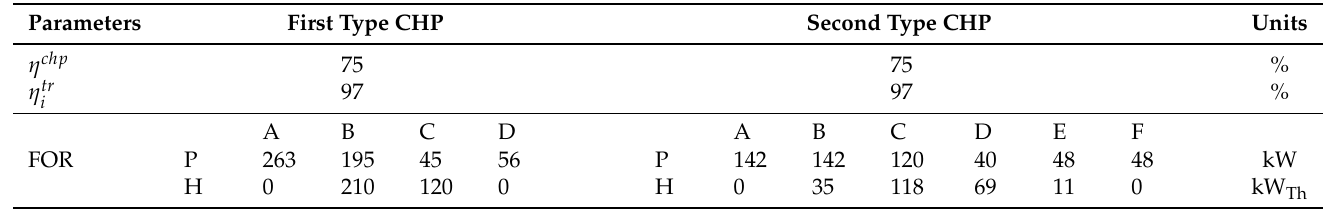
Figure 5. The plot of thermal and electrical power of prosumer and the retailer’s fixed load. Table 2. Parameters of CHP units.